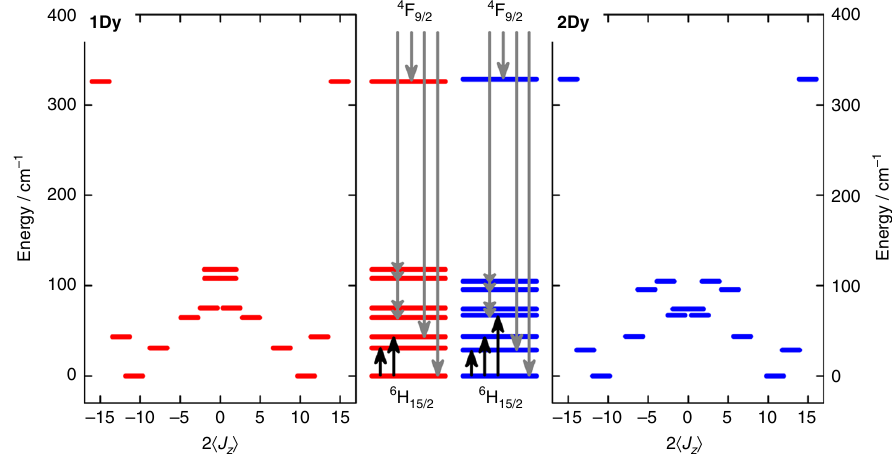
Fig. 2 Crystal fi eld splittings. Energy versus 2 〈 J z 〉 for the crystal fi eld states of the ground 6 H 15/2 multiplet for 1Dy and 2Dy corresponding to the CF parameters in Table 1. In the center panel, showing the eight Kramers doublets, the black arrows denote the observed INS transitions, while the grey arrows denote the individual transitions observed for the 4 F 9/2 → 6 H 15/2 emission line. Of the latter type, the multi-headed arrows denote the four excited doublets fully or partially assigned to the broad maximally intense band in the luminescence spectra of 1Dy (Fig. 3a), and 2Dy (Fig.